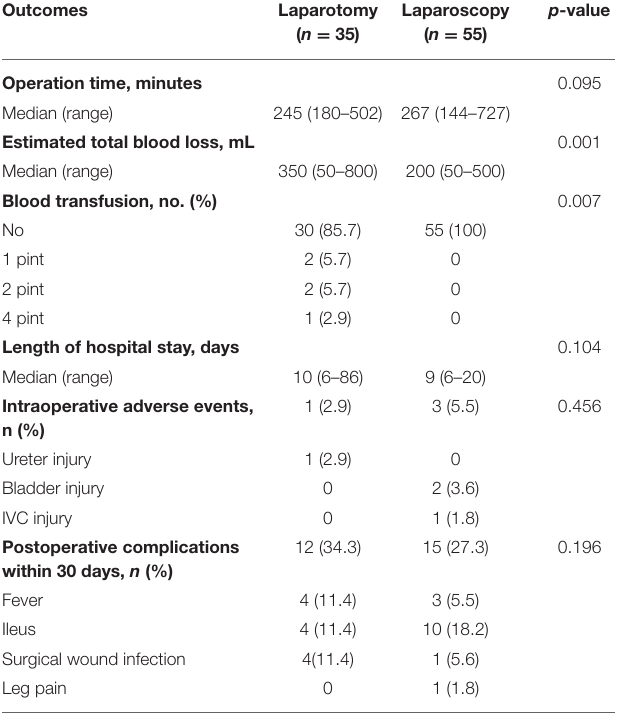
TABLE 3 | Perioperative and postoperative outcomes per surgical modality.